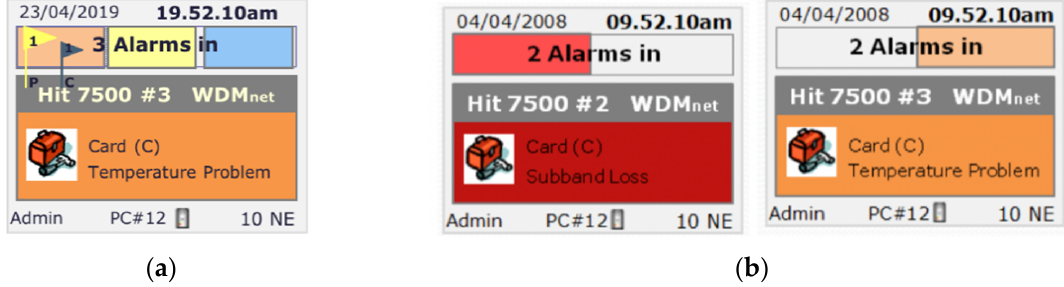
Figure 6. Redefinition of the display format in the case of multiple notifications: ( a ) Multiple faults in the same NE (Case 1) and ( b ) sequence of multiple faults in two NEs (Case 2).